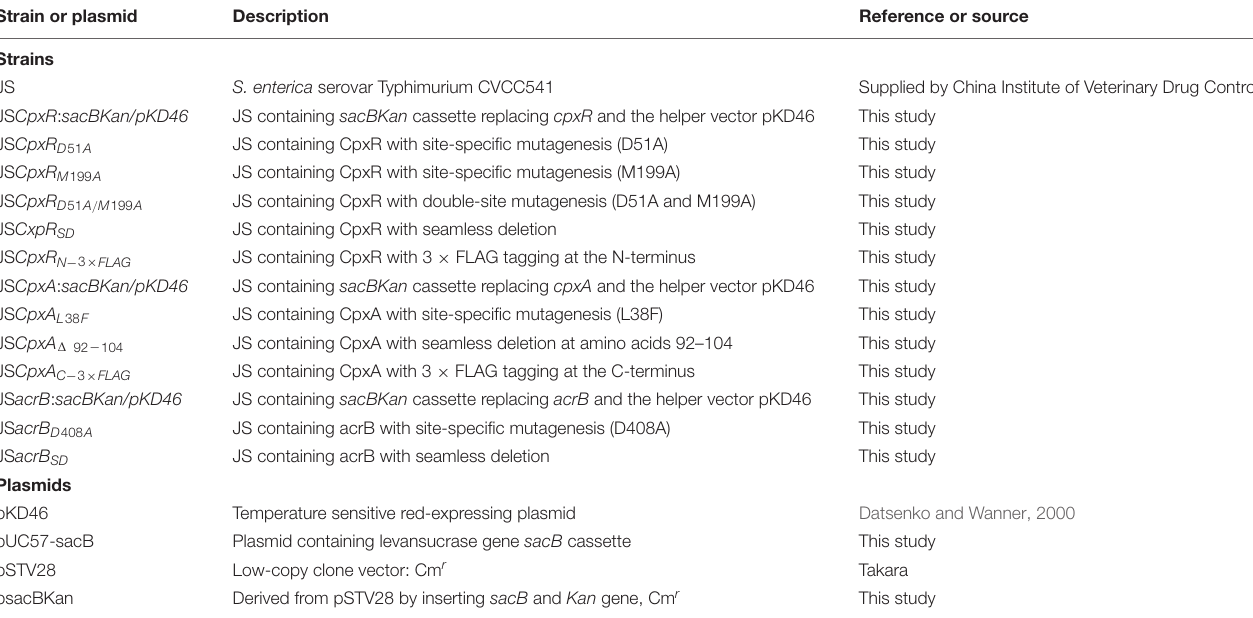
TABLE 1 | Salmonella strains and plasmids used in this